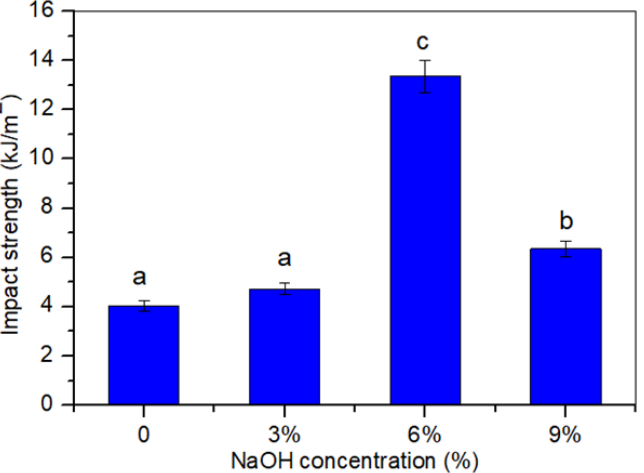
Figure 4. The ( a ) flexural strength, and ( b ) flexural modulus of untreated and treated TPCS/PW/CCF composites at different NaOH concentrations. Letters a, b, and c is indicates the group of data for statistical analysis.